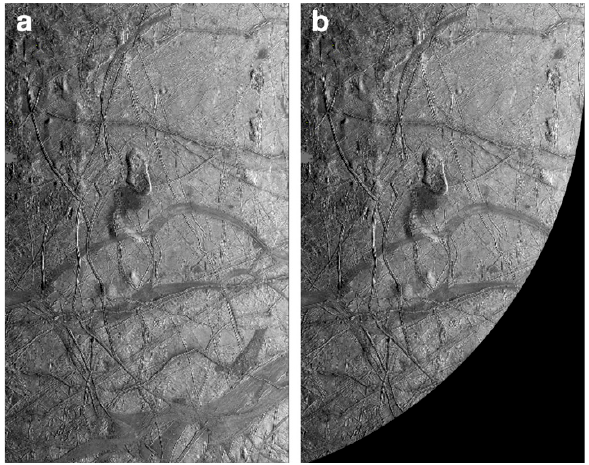
Figure 5. “Truth” image used for testing, a mosaic of six Galileo images at 210 m/pixel, covering 294x472.5 km centered on Castalia Macula (0.7°N, 225.3°W). (a) The mosaic does not include the limb of Europa. (b) Stenciling the mosaic with a circular mask simulates a limb view.